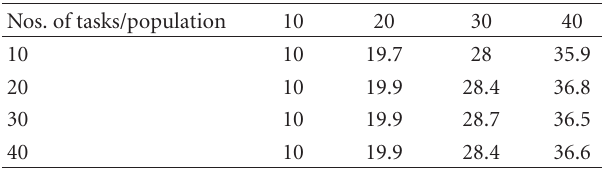
Table 3: Assignment quality versus population size.